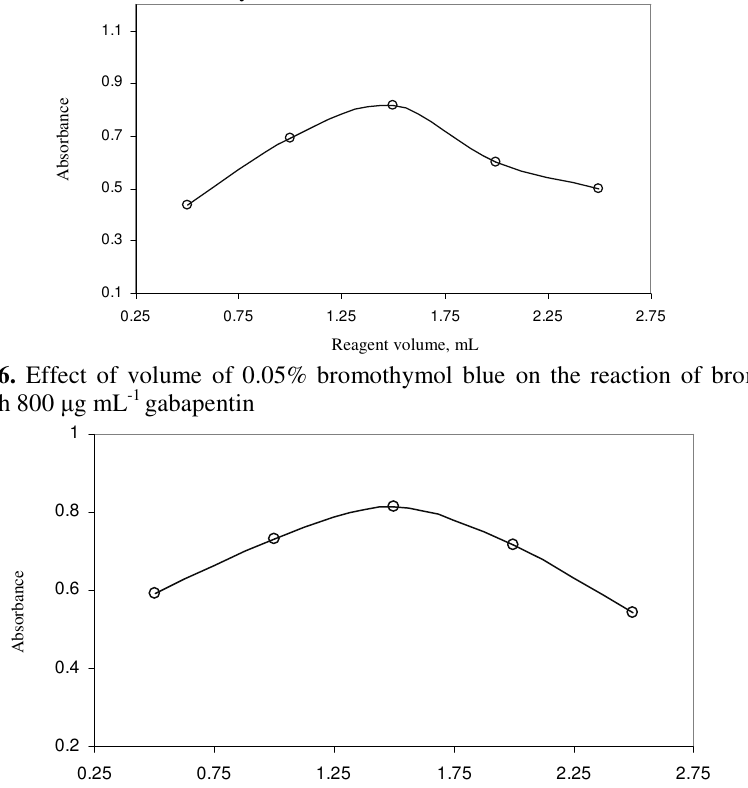
Figure 5. Absorption spectra of the ion pair formed through reaction of: 800 µ g mL -1 gabapentin with 0.05% bromothymol blue blank solution